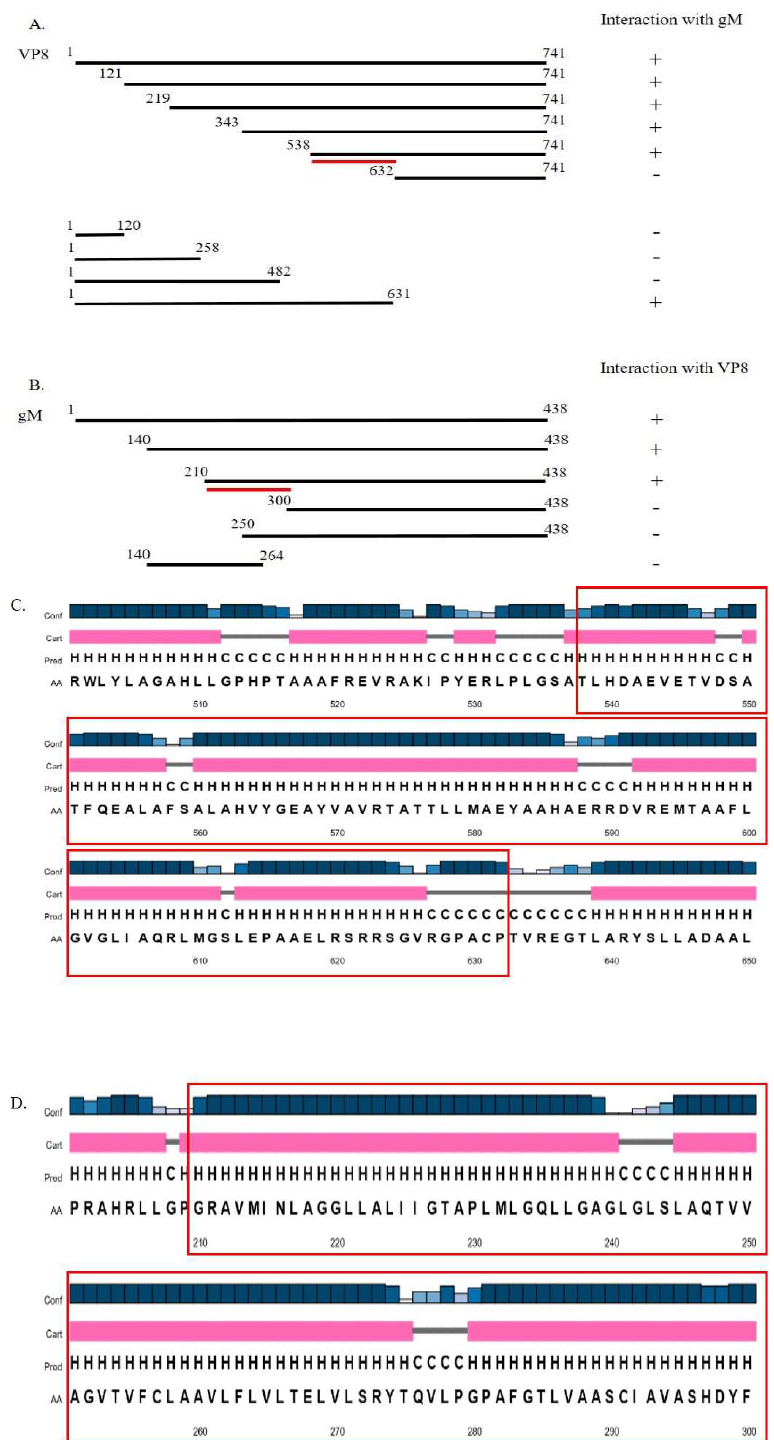
Figure 8. Representation of the domains of VP8 and gM that interact with each other. ( A ) Schematic representation of interaction between truncated versions of VP8-FLAG with full-length gM-HA. ( B ) Schematic representation of interaction between truncated versions of gM-HA with full-length VP8- FLAG. ( C ) Predicted secondary structure of the domain of VP8-FLAG (538–632) involved in the interaction with gM-HA. ( D ) Predicted secondary structure of the domain of gM-HA (210–300) in- volved in the interaction with VP8-FLAG.